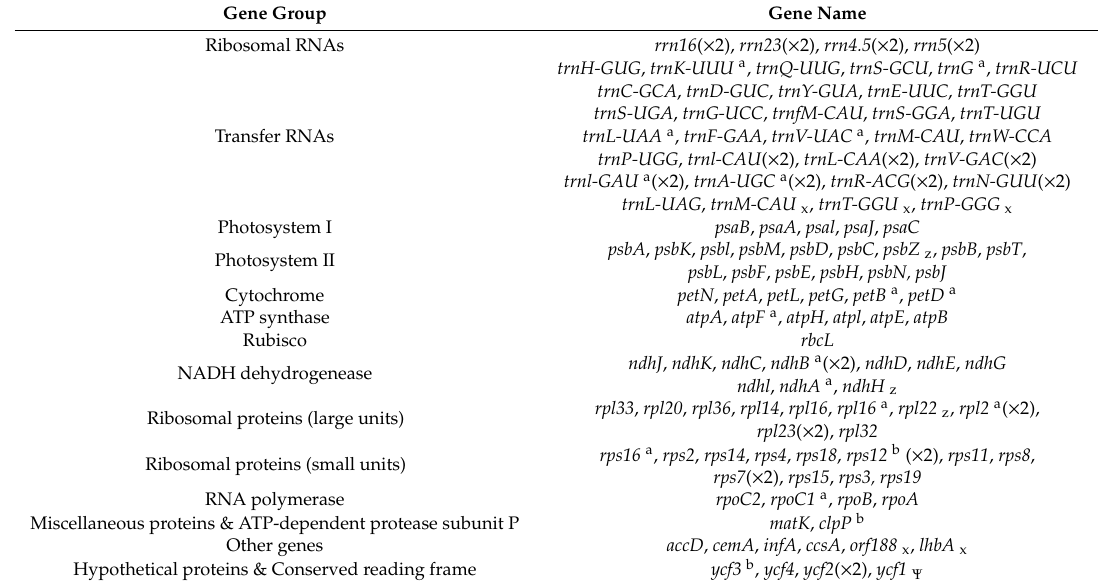
Table 2. Gene composition in the 24 Adoxaceae chloroplast genomes.